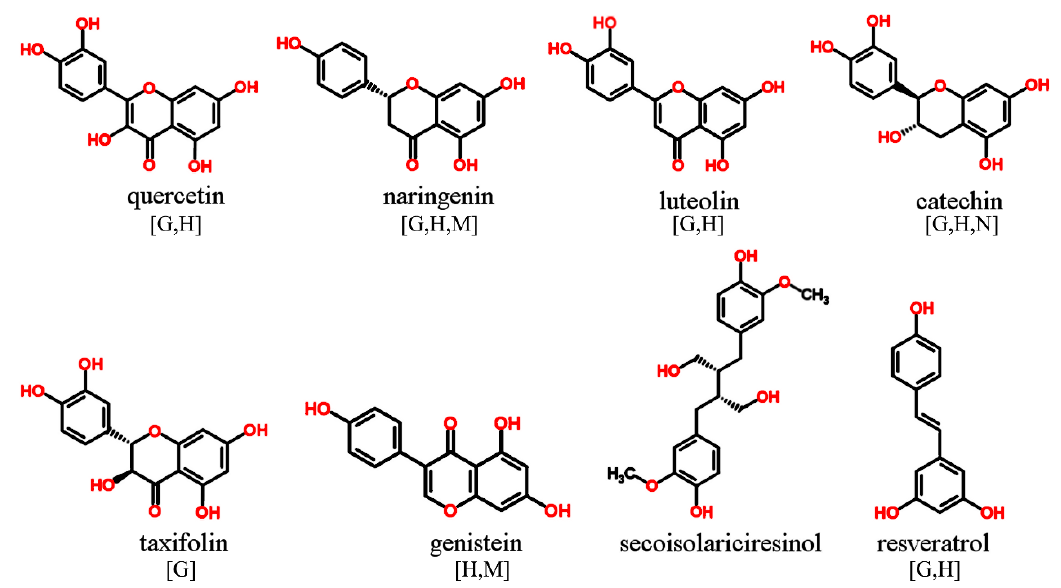
Figure 3. Polyphenols detectable in GC-MS profiling experiments. MS spectra included in publically available databases.